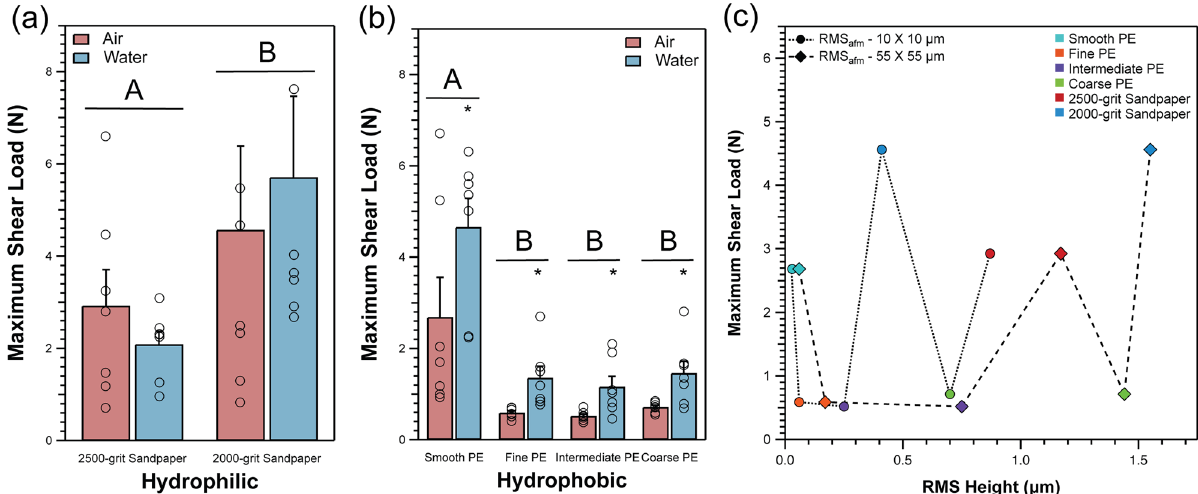
Figure 2. ( a ) Mean maximum shear load of live geckos tested on 2500-grit and 2000-grit hydrophilic sandpapers. ( b ) Mean maximum shear load of geckos tested on four hydrophobic polyethylene (PE) substrates that vary in surface roughness. Bars with different letters indicate statistically significant differences in adhesive performance as a function of substrate (i.e., bars with the same letter are not statistically different from one another). Stars represent statistically significant differences in adhesive performance as a function of surface water treatment (presence or absence; i.e., means without a star are not statistically different from one another). Open circles represent the raw data points of each individual gecko. Error bars are mean ± 1 s.e.m. ( c ) Mean maximum shear load of live geckos in air as a function of RMS height measured via AFM (RMS afm ; at two different scan sizes). Lines merely connect individual points; they are not statistical fits.